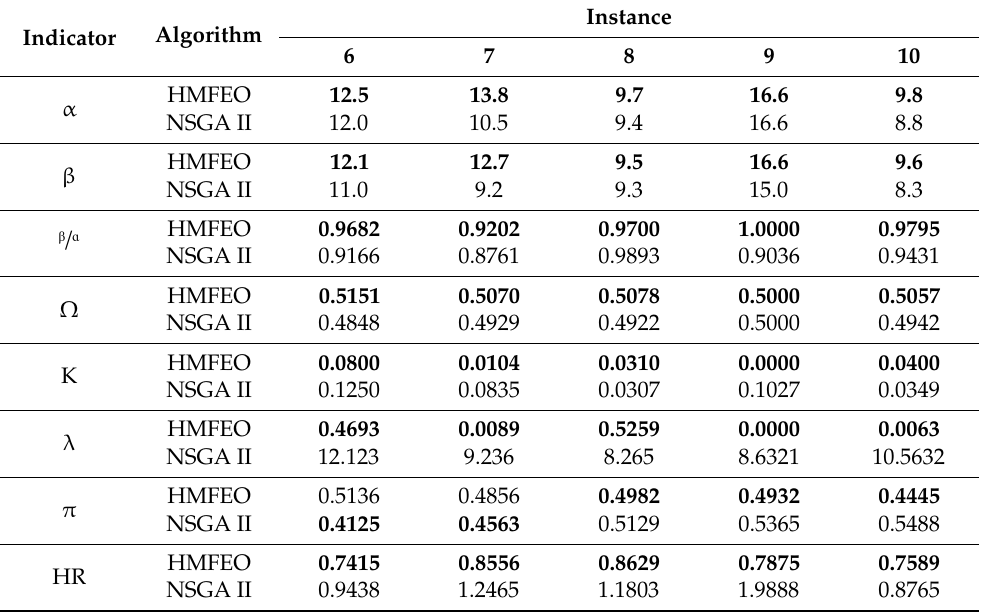
Table 11. Results of performance indicators for comparison of HMFEO and NSGA II instance 6–10.